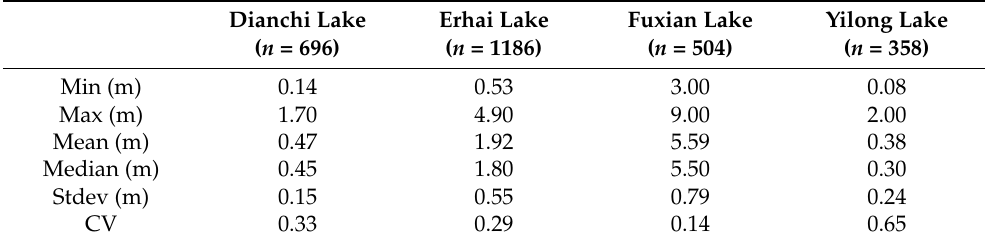
Table 1. Statistics of the measured SD for the four lakes. CV (coefficient of variation) = Stdev/Mean. Dianchi